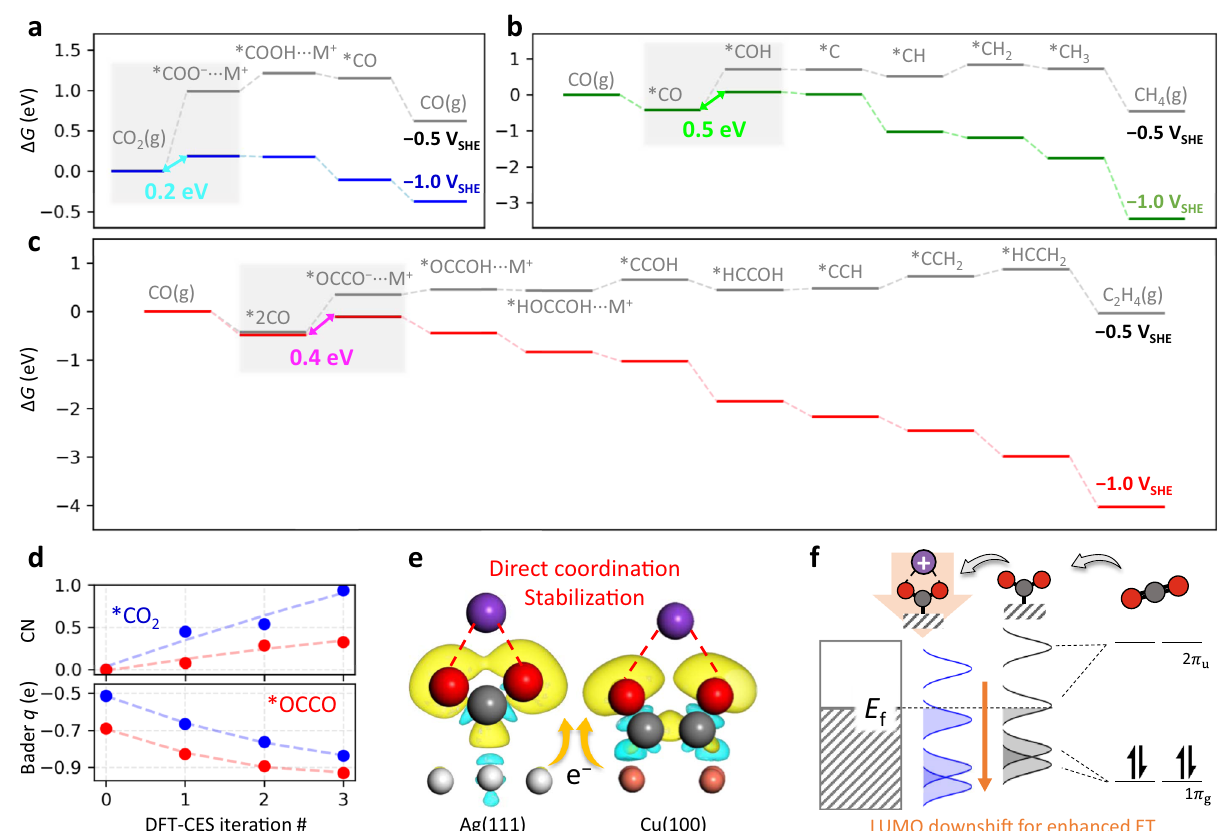
Fig. 2 | Reaction energy diagrams and cation-coupled electron transfer. a – c , Reaction free energy ( Δ G ) diagrams for CO 2 -to-CO on Ag(111) ( a ), CO-to-CH 4 on Cu(100) ( b ), and CO-to-C 2 H 4 on Cu(100) ( c ). Applied potentials are − 0.5 and − 1 V SHE . The asterisk (*) indicates the adsorbed state, and the energetically favorable paths, among other possibilities (Supplementary Fig. 6) are selectively shown. The cation-coordinated intermediates are speci fi ed by appending ···M + . The RDS is denotedbyagrey-shadedregion. d ,ChangeinCNofK + tothe*CO 2 and*OCCO,and that in the Bader charge (Bader q ) of those two intermediates during DFT-CES iterations at − 0.5 V SHE . e , Cation coupling to the intermediates not only stabilizes them, but also helps an electron transfer to them from the metal electrodes. Iso- surface shows a charge difference between the cation-uncoupled case at the 0 th iterationstepandthecation-coupledcaseatthelastiterationstep(isosurfacevalue